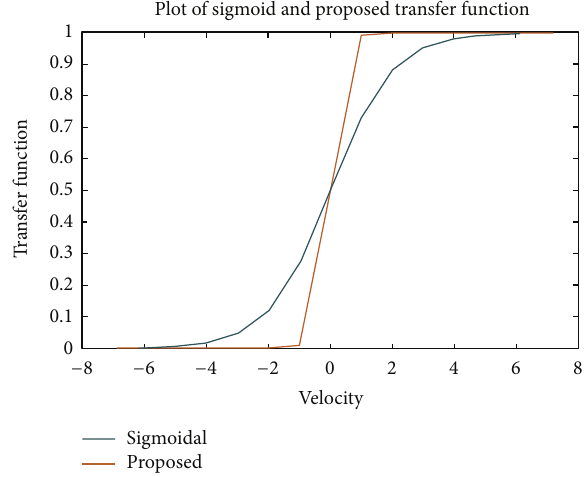
Figure 3: The proposed transfer function used to flip binary